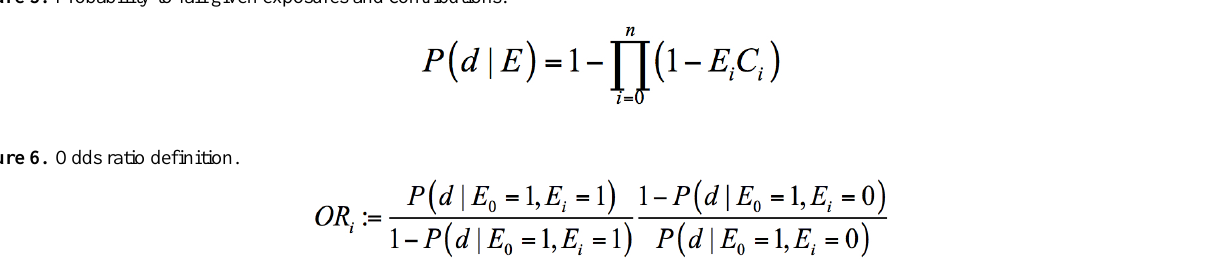
Figure 7. Approximated odds